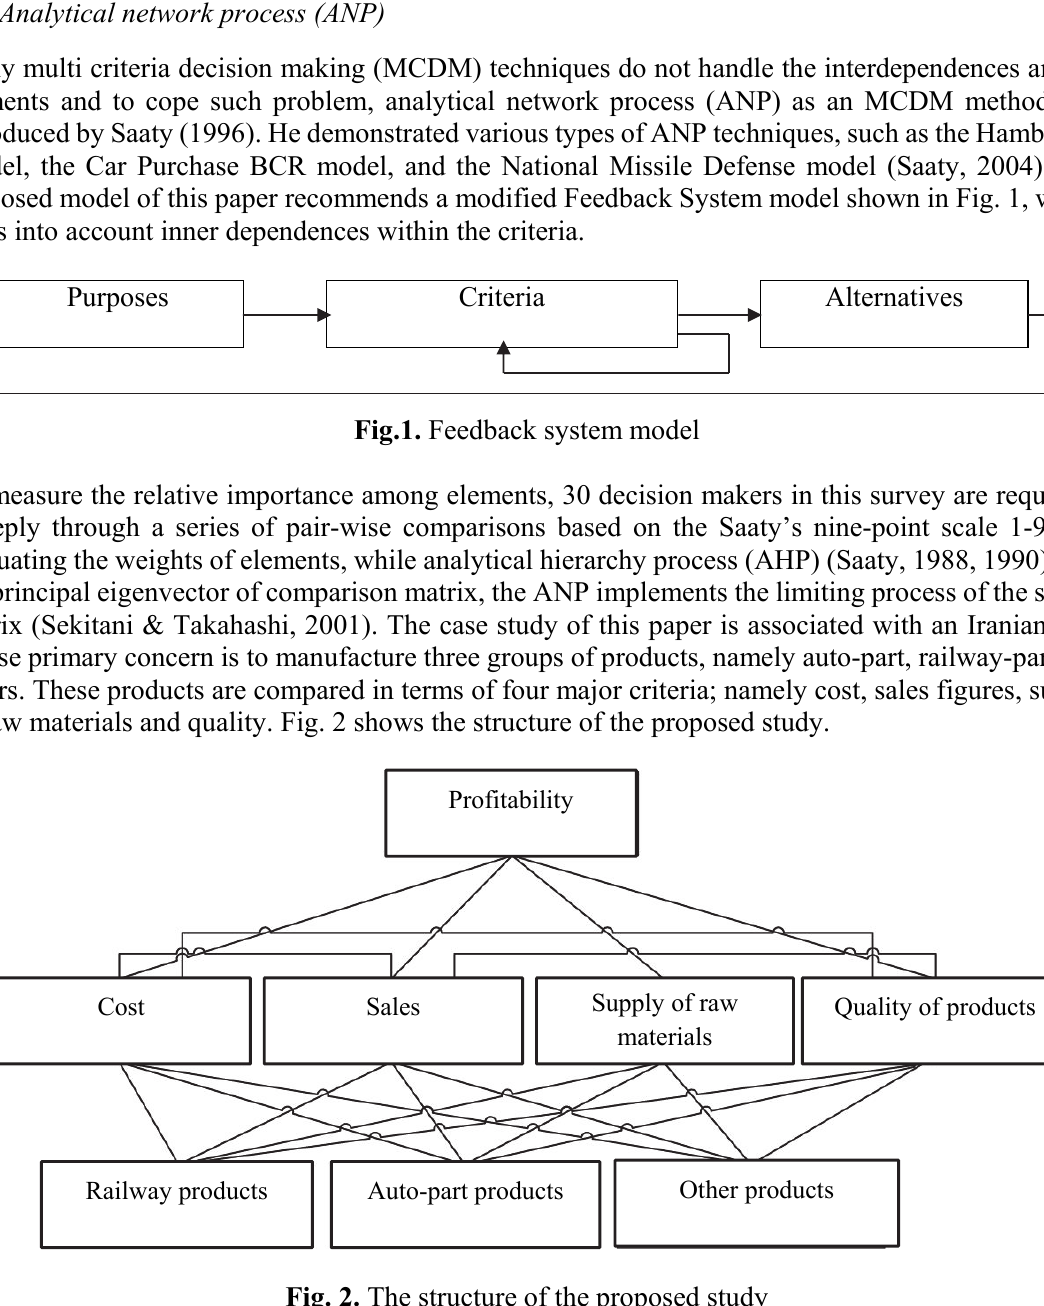
Fig. 2. The structure of the proposed